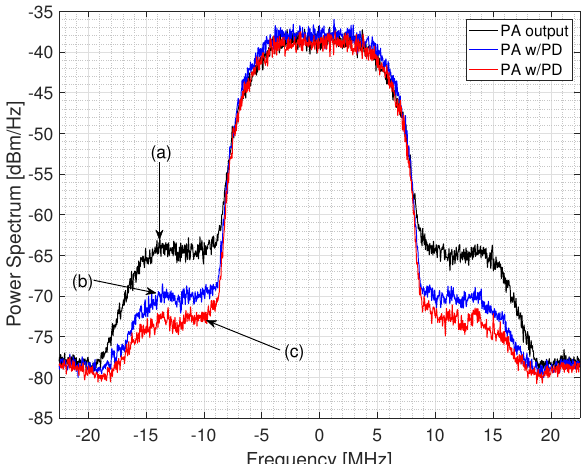
Figure 13. Spectral regrowth of the QPSK 18–MHz; ( a ) PA Output (Saleh model), ( b ) with PD ( K = 4, M = 1), ( c ) with PD ( K = 6, M =